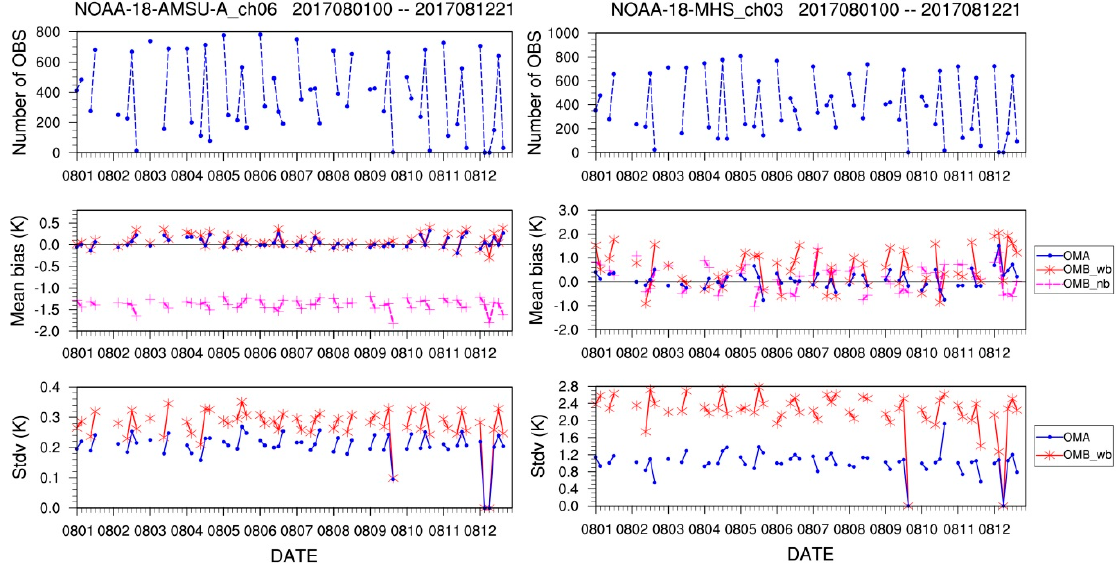
Figure 5. The number of observations, mean bias, and standard deviation (Stdv) of AMSU-A channel 6 and MHS channel 3 of NOAA-18 for OMB without (OMB_nb) and with (OMB_wb) bias correction and OMA, valid from 0000 UTC on 1 August 2017, to 2100 UTC on 12 August 2017. OMB: observation minus background; OMA: observation minus analysis.